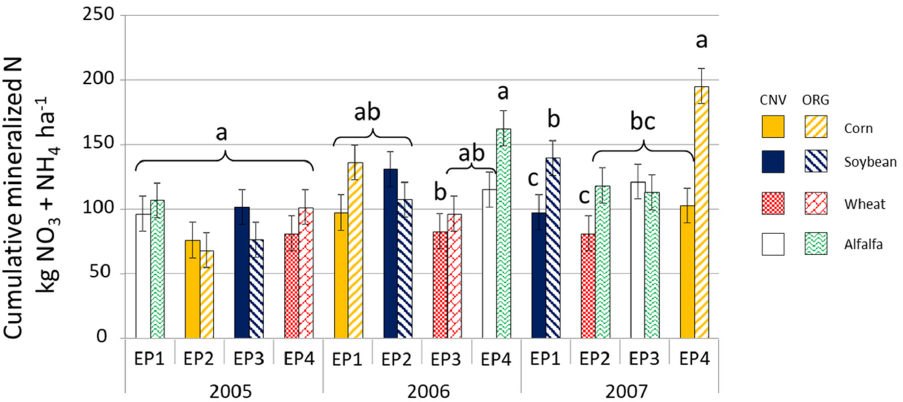
Figure 4. Cumulative net mineralized N (kg NO 3 − -N + NH 4 + -N ha − 1 ) in the 0–9 cm depth, for each crop by initial crop rotation entry point (EP) for conventional (CNV) and organic (ORG) management systems for the 2005 through 2007 growing seasons. Note: CNV wheat was under-seeded with alfalfa in all years; ORG wheat was under-seeded with alfalfa only in 2005, then dropped from the rotation in 2007. Bars show standard error of the mean. Significant differences among the eight system by entry point treatments within each year, as established by Bonferroni adjusted multiple comparison tests, are indicated by different lowercase letters ( p < 0.05). Crop rotation EP is defined in Figure 2. Averaged over all entry points, Nmin rate increased over time for 2005, 2006, and 2007, respectively, from 0.8 to 1.4 to 1.9 kg ha − 1 d − 1 in ORG and from 0.8 to 1.2 to 1.3 kg ha − 1 d − 1 in CNV. Broken down by entry point, Nmin-rate in the ORG notably increased each year under all entry points, but in the CNV appeared to change inconsistently (Figure 5). The increase in ORG Nmin-rate aligned with the observed increase in ORG corn yields and was consistent with the benefits of accumulating N inputs suggested by Seufert et al. [46]